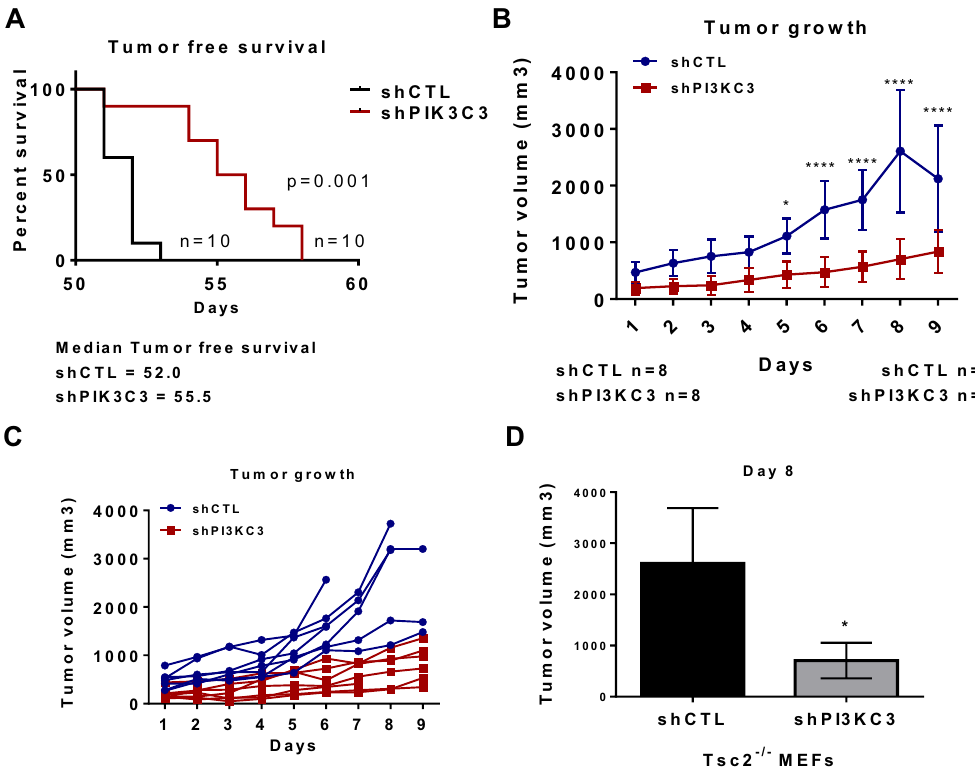
Figure 5. Vps34 downregulation decreases proliferation of Tsc2-deficient cells in vivo . Mice were injected subcutaneously with 2.5 × 10 6 Tsc2 − / − shCTL or shPI3KC3 MEFs. Mice bearing tumors > 100 mm 3 were identified by palpation. ( A ) Tumor latency was increased in Tsc2 − / − shPIK3C3, compared to Tsc2 − / − shCTL tumors. Statistical significance was assessed by Mantel-Cox Test with p = 0.001. ( B ) Tumor volume was decreased in the shPI3KC3 tumors compared to shCTL tumors. ( C ) Growth of individual shCTL and shPI3KC3 tumors. ( D ) Tumor volume at 8 days after palpation. Data presented as mean + / − standard deviation. Statistical significance was assessed by Student’s unpaired t-test with * p < 0.05, **** p <